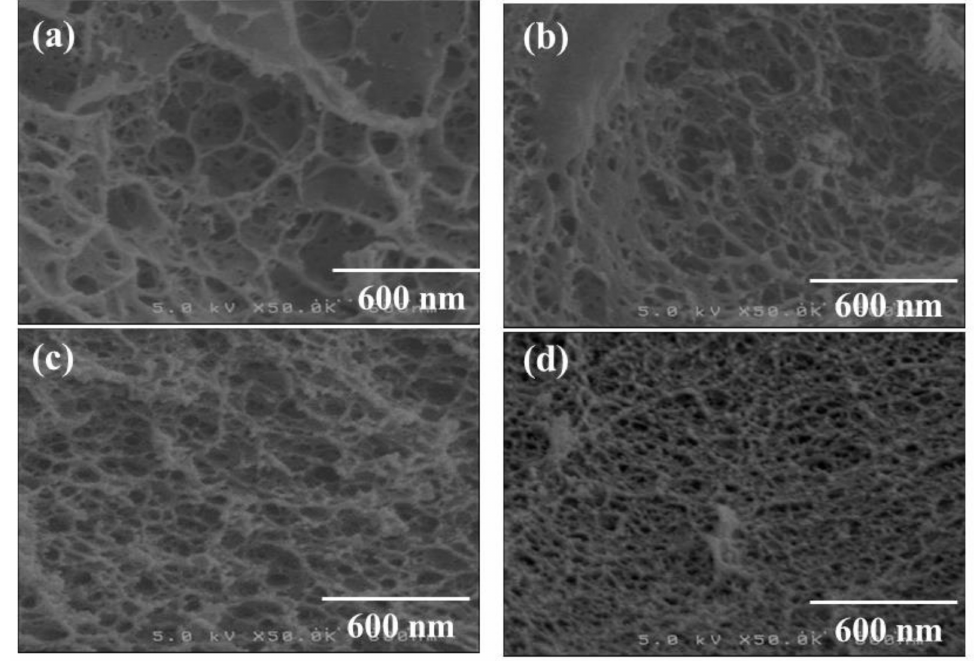
Figure 2. SEM images of regenerated celluloses obtained by the lyophilization of the hydrogels ( a – d , Entries